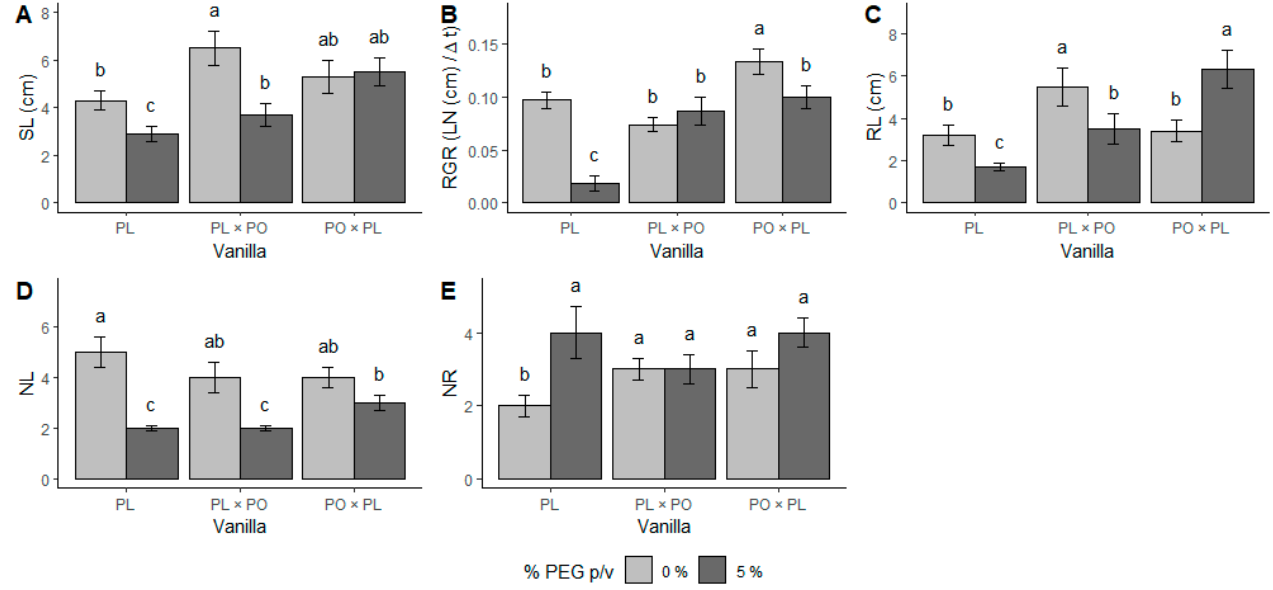
Figure 1. Water stress affects growth of Vanilla planifolia (PL) seedlings and V. planifolia × V. pompona (PL × PO) and V. pompona × V. planifolia (PO × PL) hybrids. ( A ) Stem length (SL); ( B ) relative growth rate (RGR); ( C ) root length (RL); ( D ) number of new leaves (NL); and ( E ) number of new roots (NR). Gray bars: 0% PEG (control group, − 0.08 mPa). Black bars: 5% PEG and hydric stress ( − 0.49 mPa). Bars with different letters are significantly different ( p < 0.05), according to GLM test.